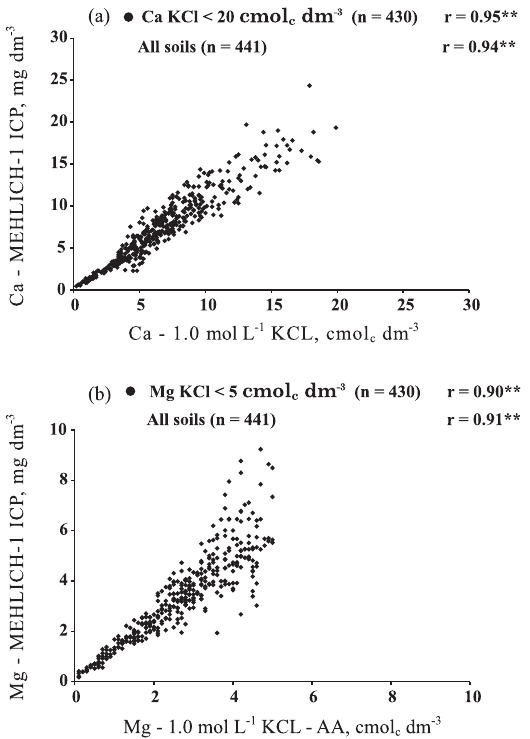
Figure 2. Correlation between the calcium (a) and magnesium (b) amounts extracted by the 1.0 mol L -1 KCl solution determined by the atomic absorption spectrometry (AA) and the calcium and magnesium amounts extracted by the Mehlich-1 solution determined by the ICP method (a).